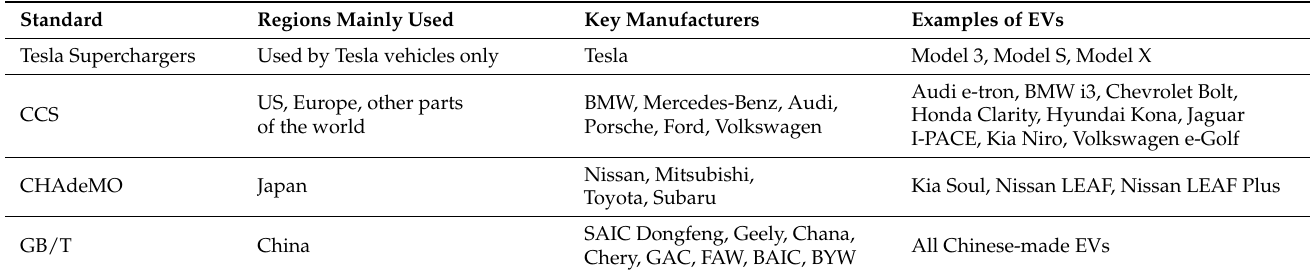
Table 5. Charging standards and their key manufacturers.